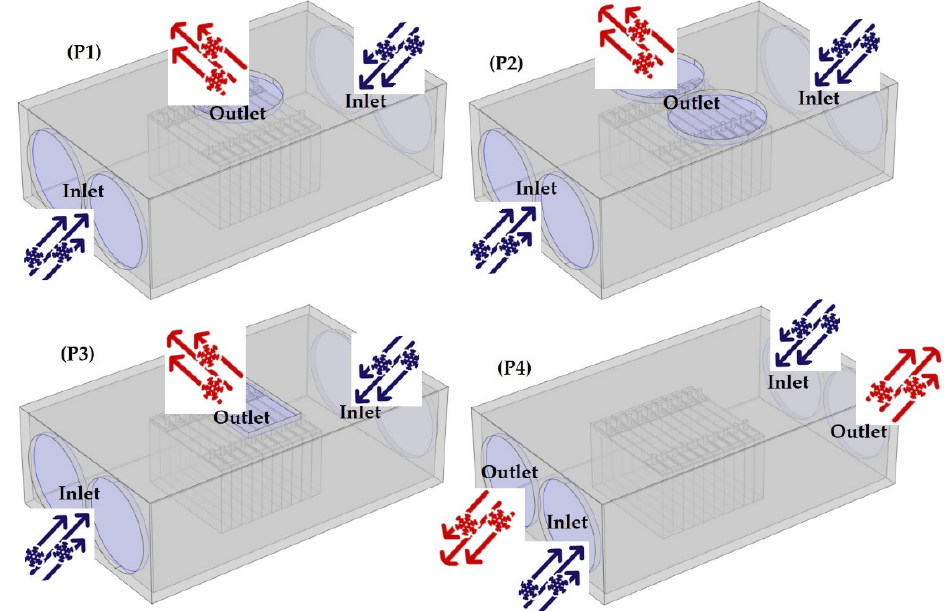
Figure 11. Four different inlet and outlet positions for the forced ACTMS; (P1) four blowing fans from both sides and one circular outlet on the top surface; (P2) four blowing fans from both sides and two circular outlets on the top surface; (P3) four blowing fans from both sides, and one rectangular outlet on the top surface; and (P4) one fan from the right side and one fan from the left side are blowing, and one other fan from left and the other one from right sides are sucking the air.